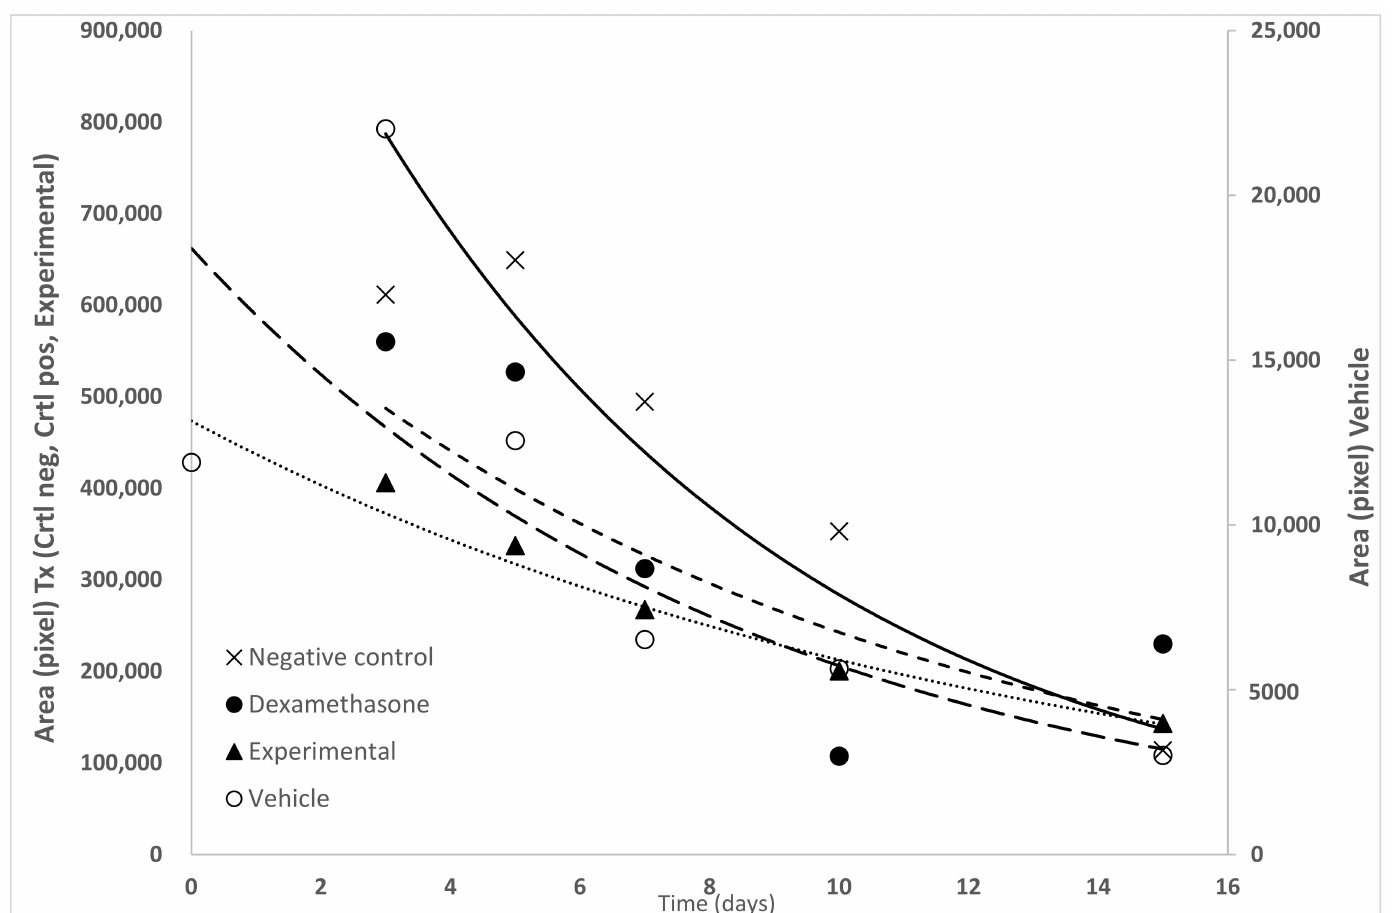
Figure 3. Effect of treatment with S. dendroideum extract by ophthalmic application, measuring the evolution of the size of the ocular lesion area, revealed by the application of Figure 2.00 × 10 6 e − 0.174x Negative control ( × × ), 6.57 × 10 5 e − 0.1x Dexamethasone treatment ( • • ), 3.45 × 10 5 e − 0.171x Vehicle treatment ( ( (cid:78) (cid:78) ) (n =